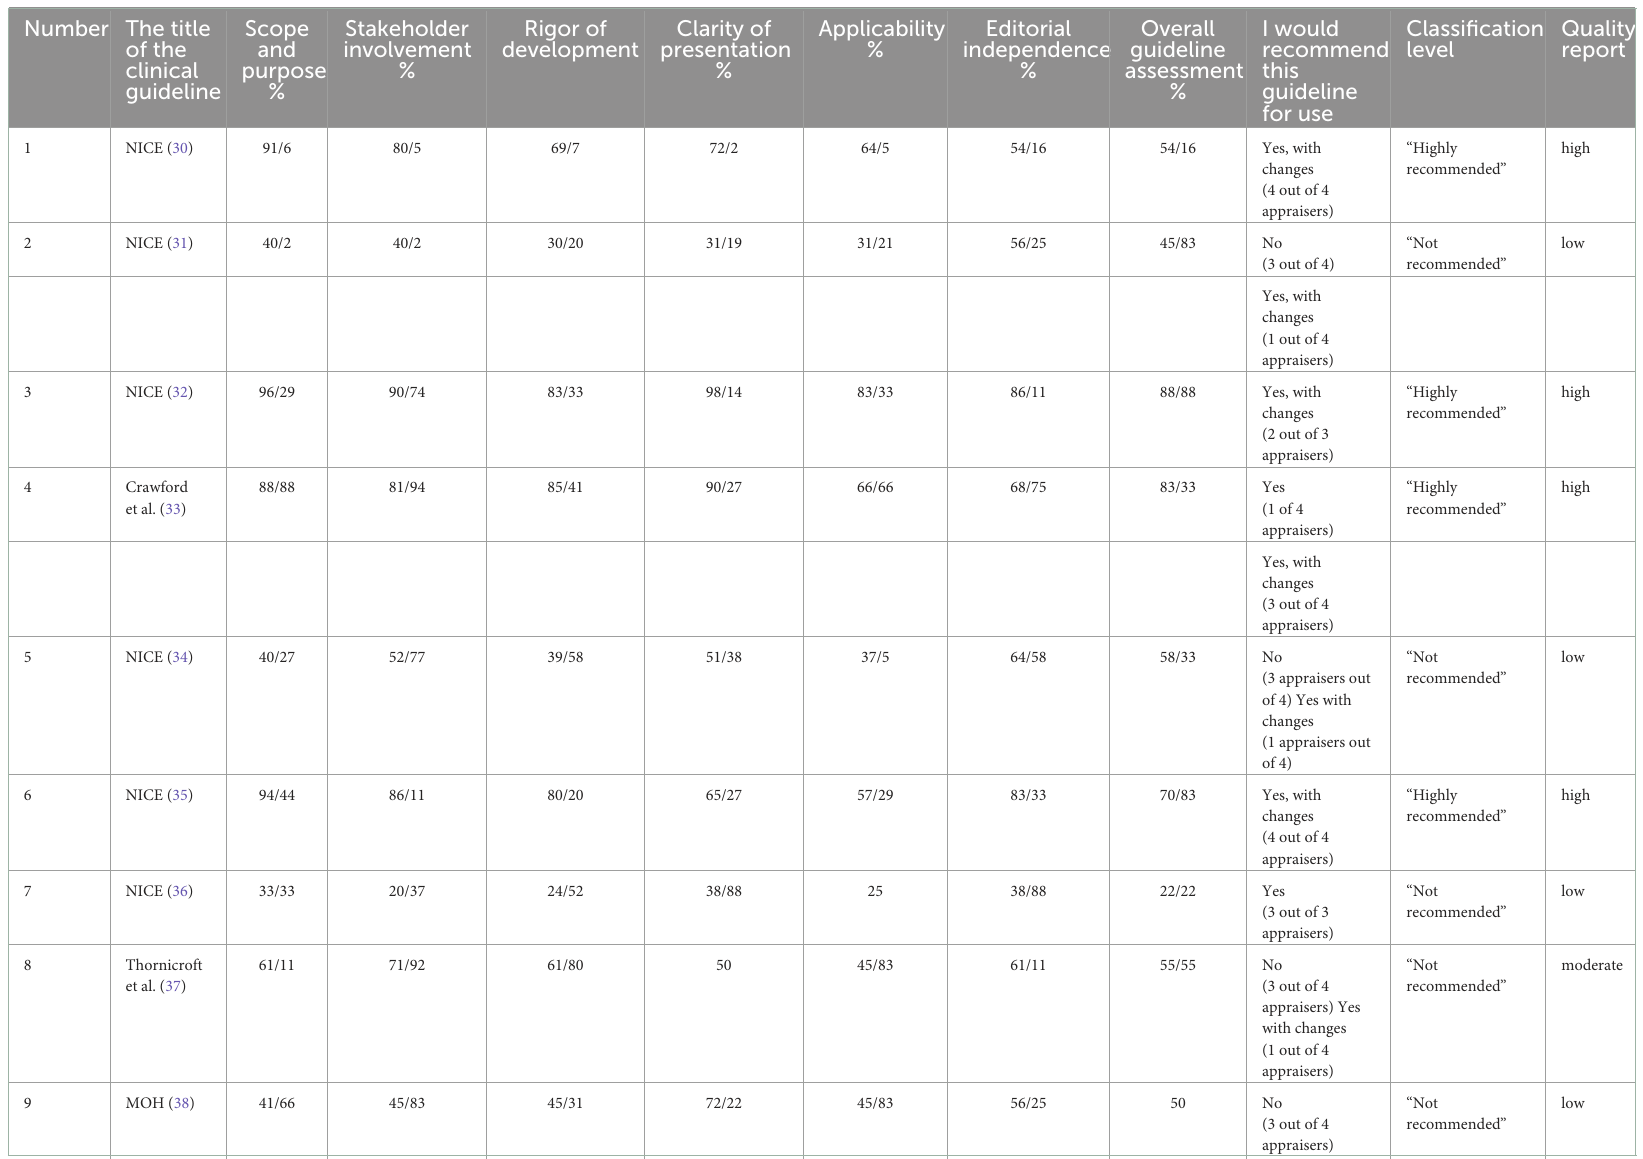
TABLE 2 AGREE II domain and overall quality scores of included